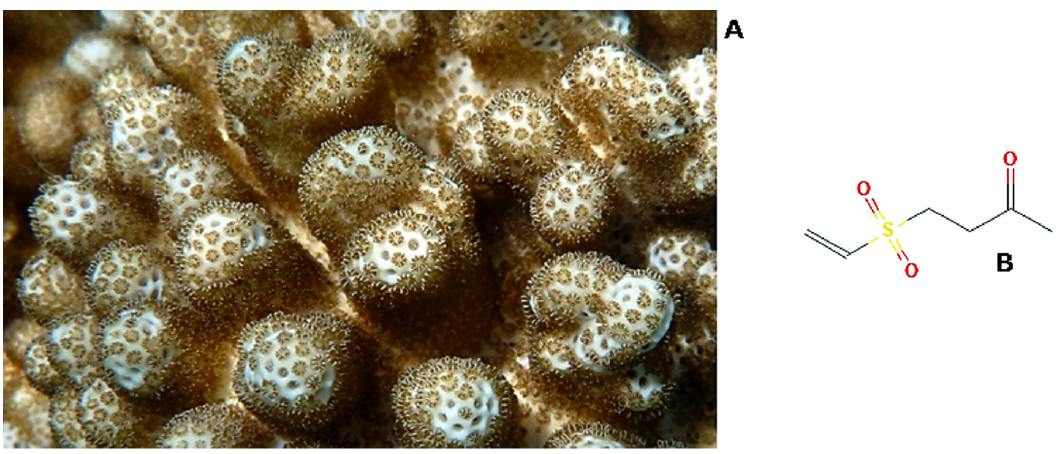
Figure 8. ( A ) A specimen of Cladiella australis soft coral © David (CC BY-NC-SA 4.0) https: // www. marinespecies.org / . ( B ) 2D structure of austrasulfone; https: // pubchem.ncbi.nlm.nih.gov / compound / 50907657#section =